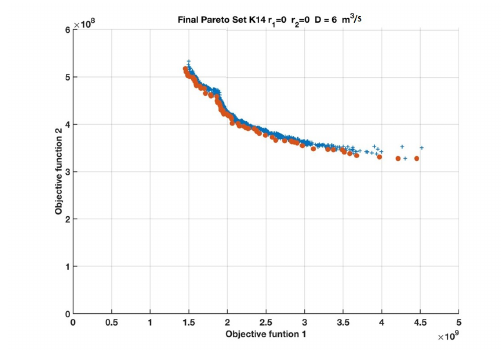
Figure 11. Pareto set for scenario 1. of Table 2.